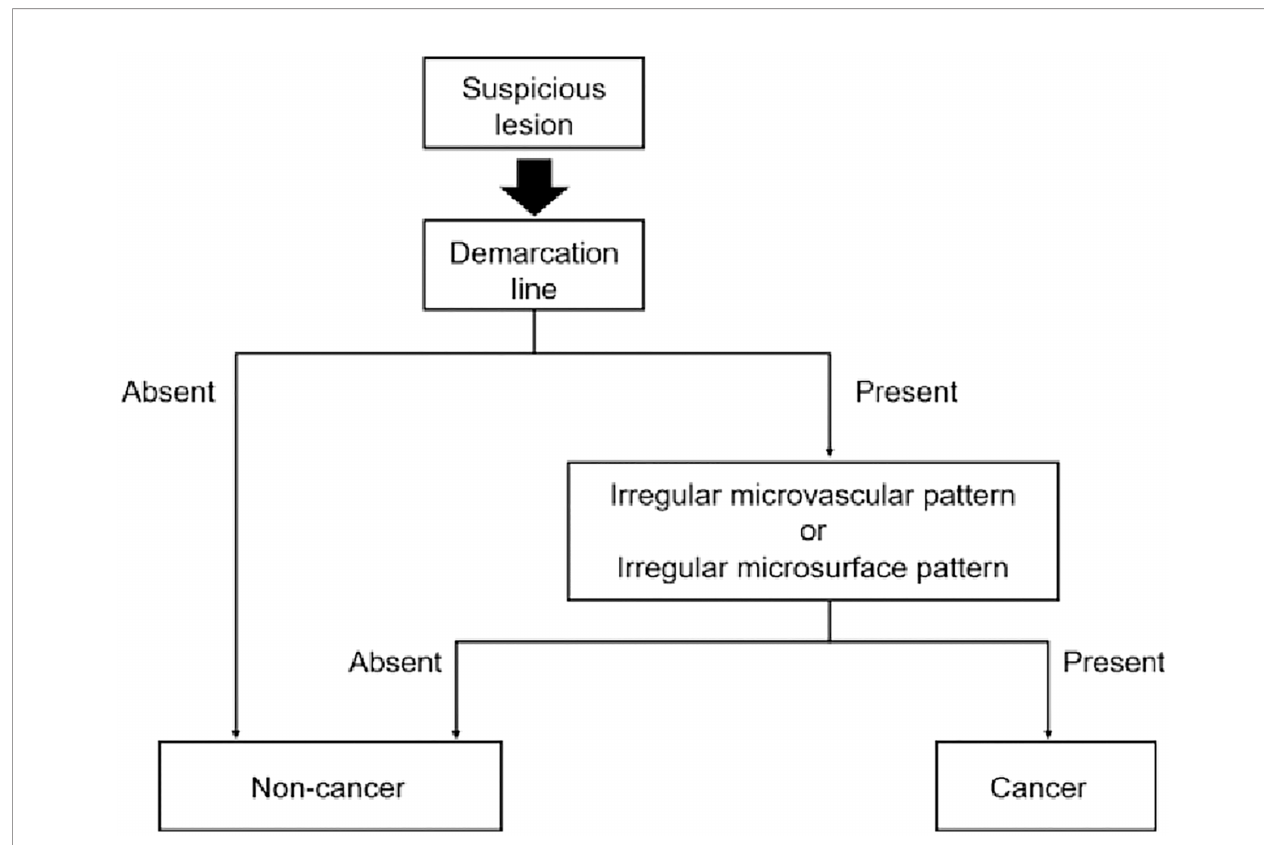
FIGURE 2 | Diagnostic algorithm for gastric cancer with magnifying endoscopy. Reproduced with permission from Yao K et al.